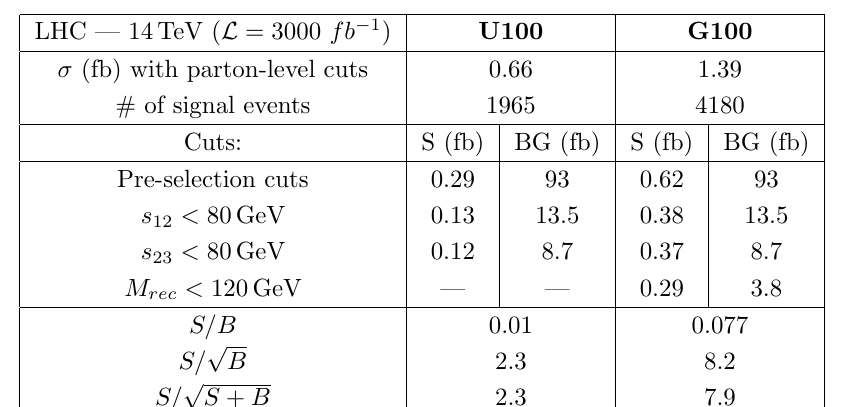
Figure 8 . Distributions of CW neutrino production signal (blue) and background (orange) events in s 12 (left panel) and s 23 (right panel) at the LHC. The signal was simulated at the G100 bench- mark point.